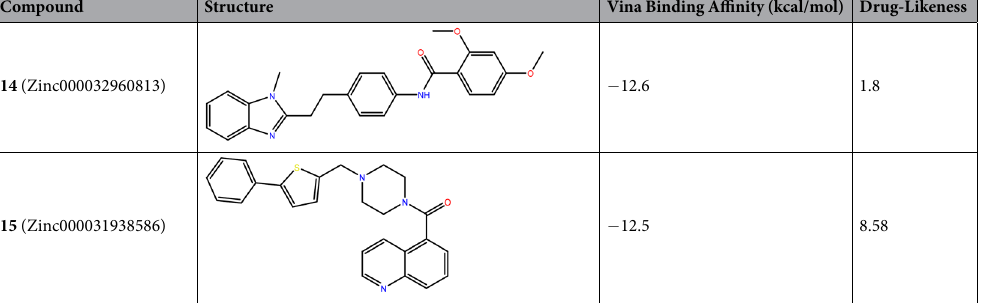
Table 1. Virtual screening results showing the top-ranked compounds that were purchased for experimental analysis.